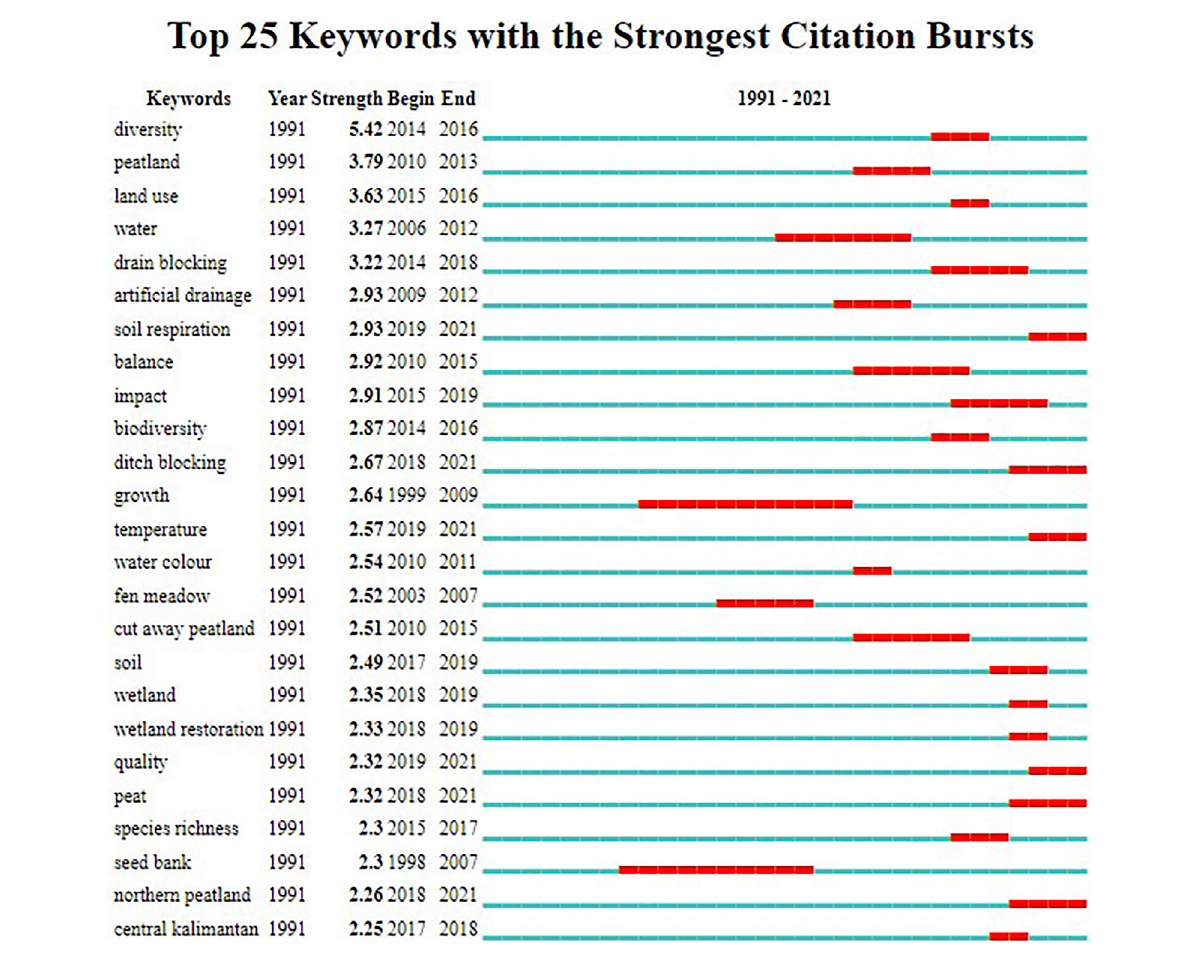
FIGURE 4 Top 25 keywords with the strongest citation bursts in the RDP (1991 –